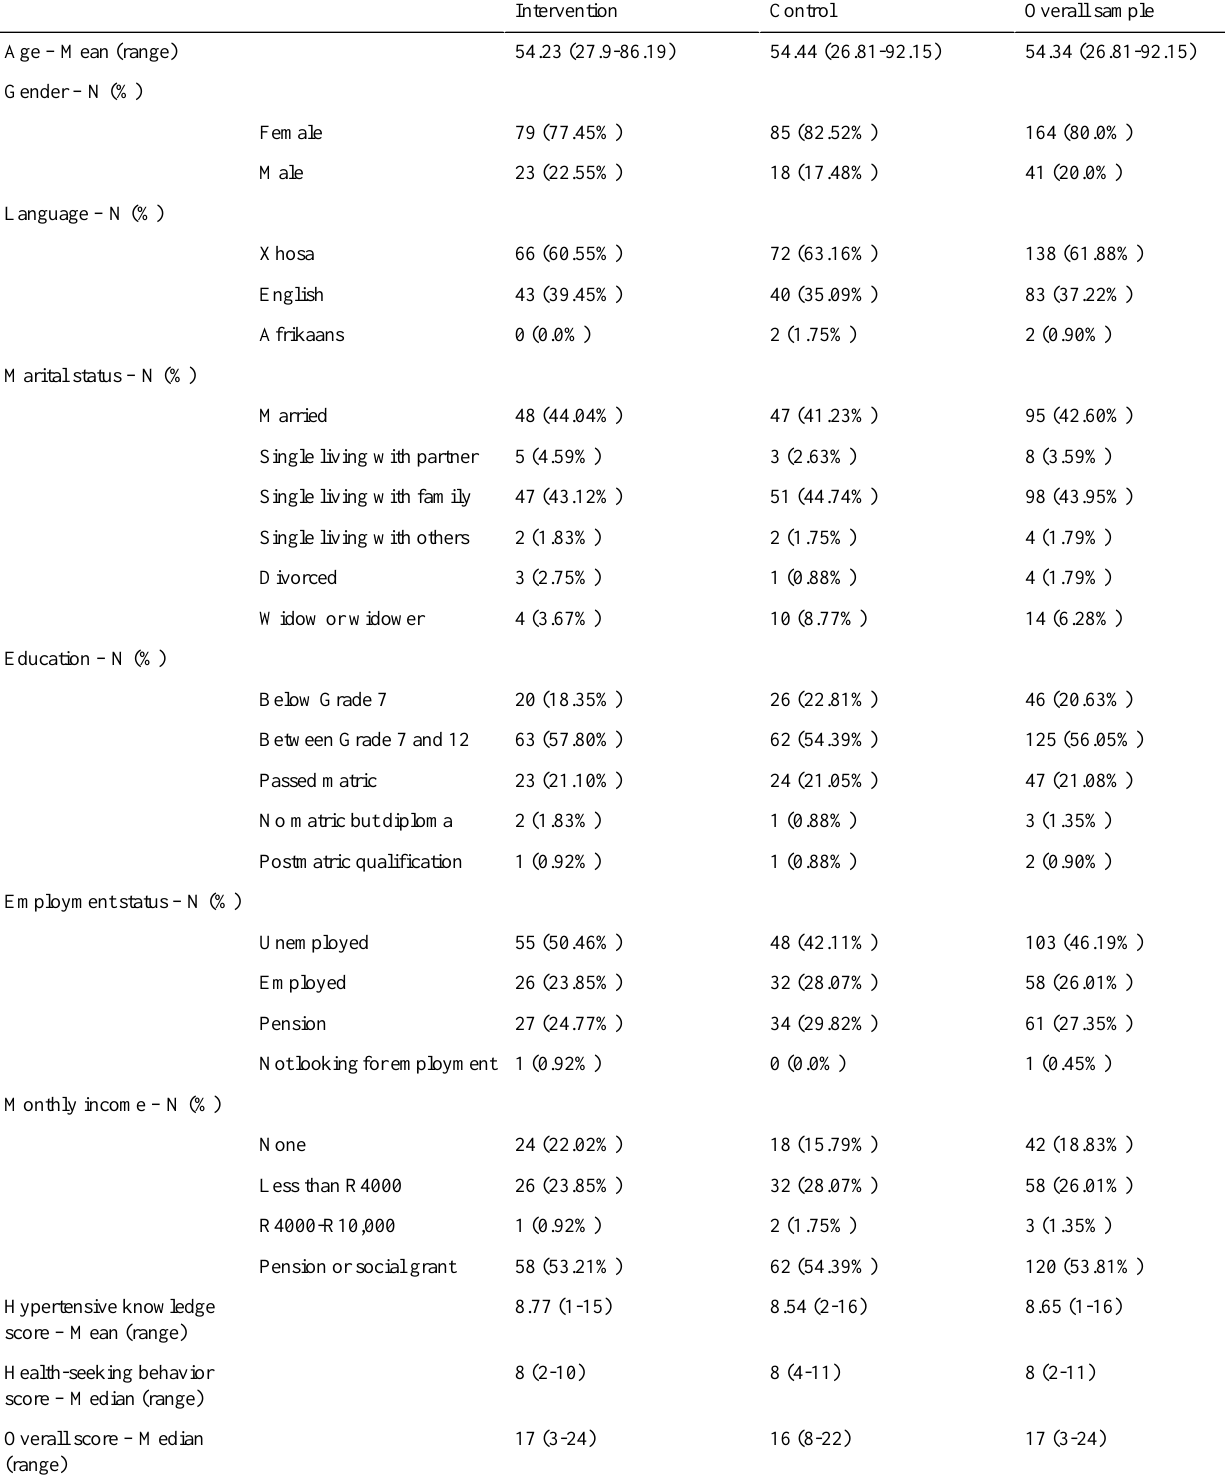
Table 1. Comparison of baseline demographics and knowledge scores between control and intervention groups.